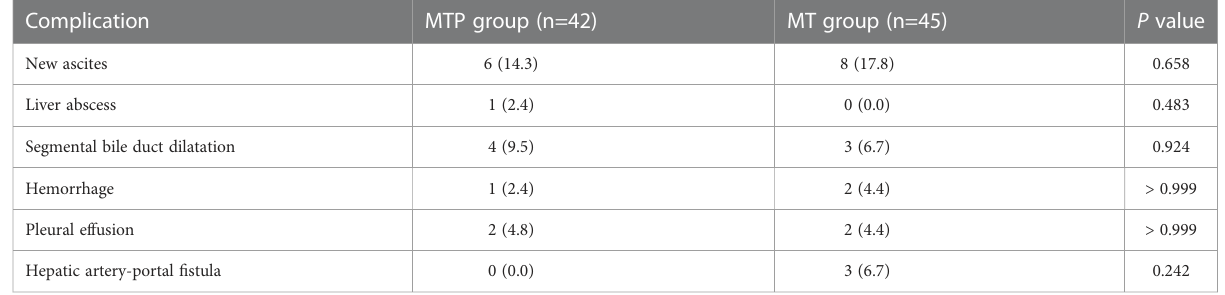
TABLE 2 Complications Related to Combination Therapy of MWA and TACE.